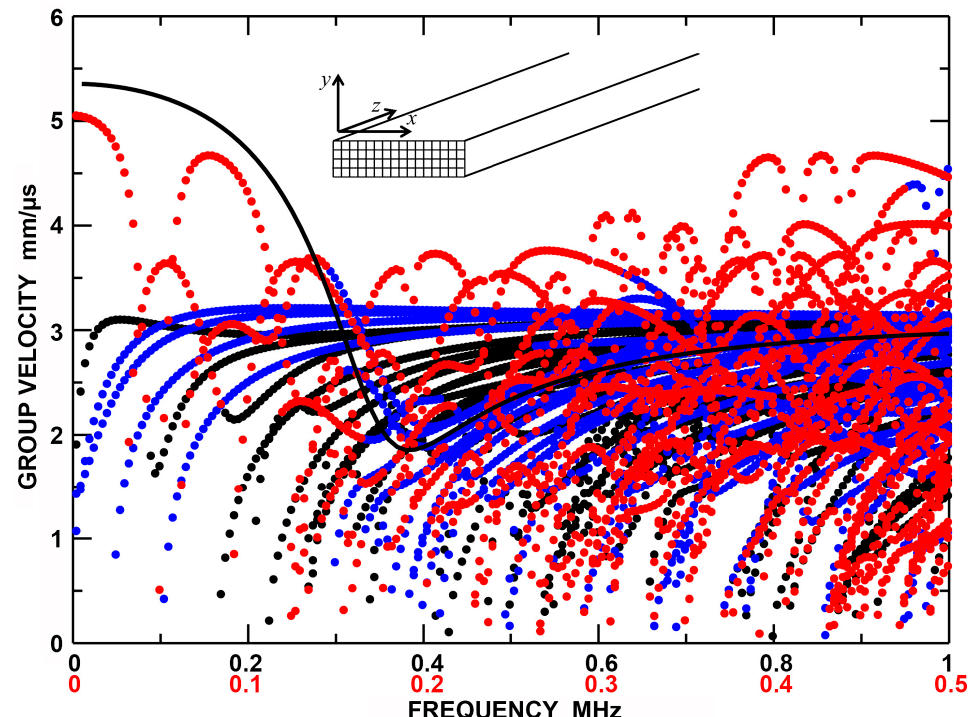
Figure 6. Dispersion curves of group velocity vs. frequency from semi-analytical finite-element [10]. Red points represent the modes dominated by z-direction displacement, blue points those by y-direction displacement and black points those by x-direction displacement. The group velocity of S 0 -mode plate wave for 6.4 mm-thick Al is drawn in as a black curve. Frequency scale for 12.7 mm thick bar is given in the second row (in red).